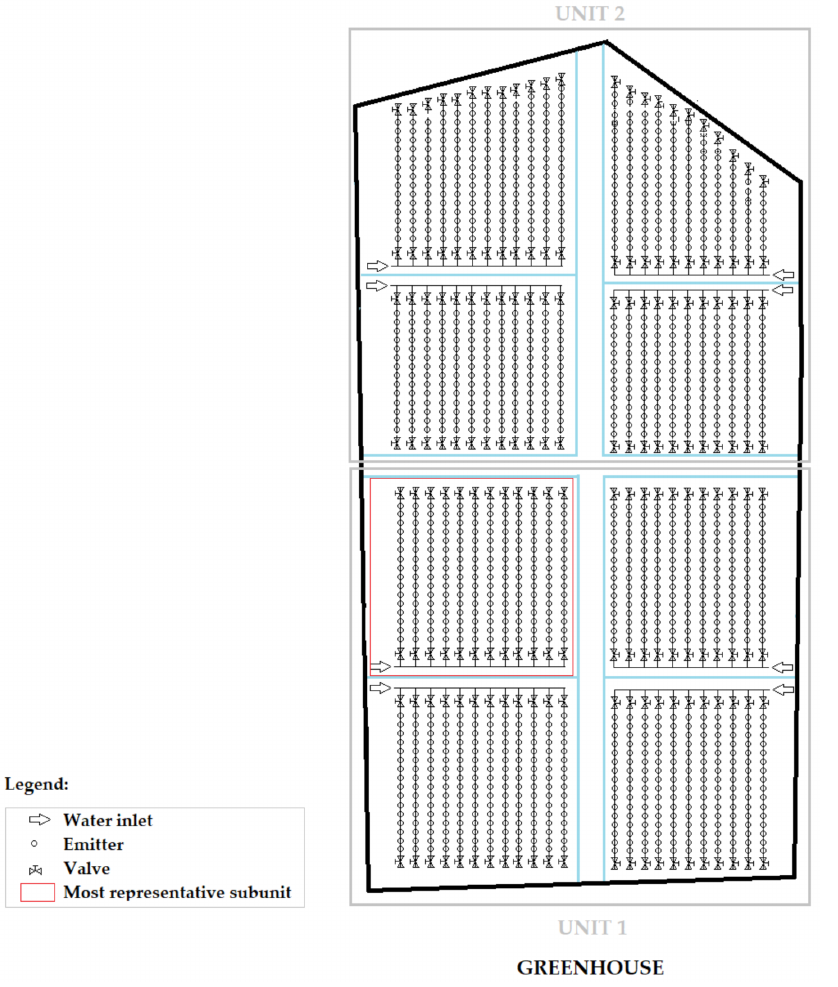
Figure 3. Choosing the most representative irrigation sub-unit in a greenhouse (size closer to 1000 m 2 ). The blue lines represent the sub-units.